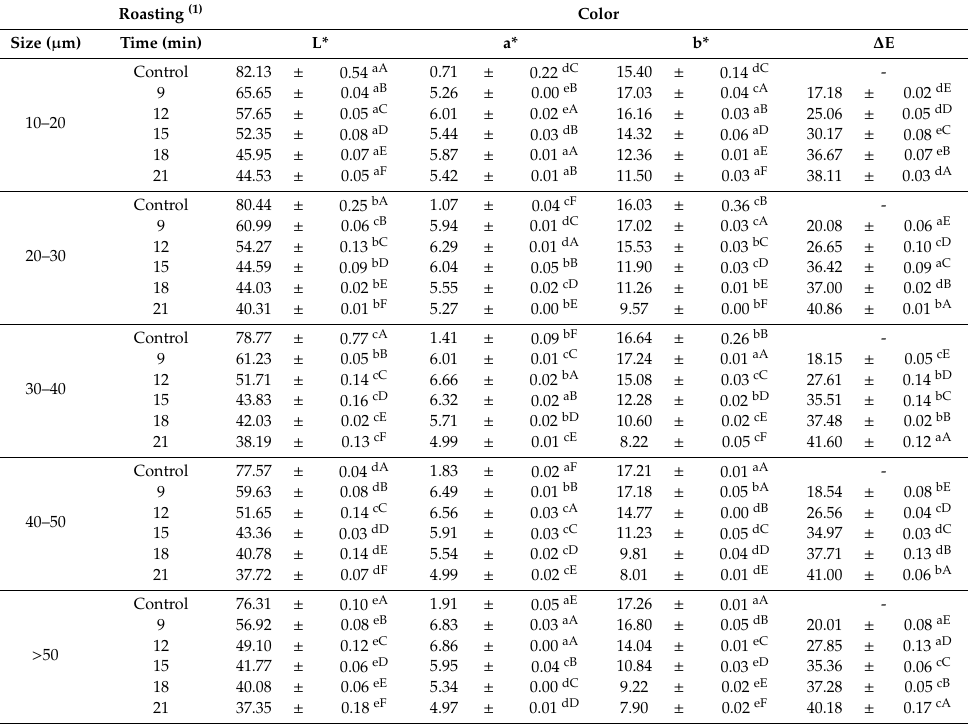
Table 3. Color of dried ginseng root powder with various roasting temperature conditions. Roasting (1)